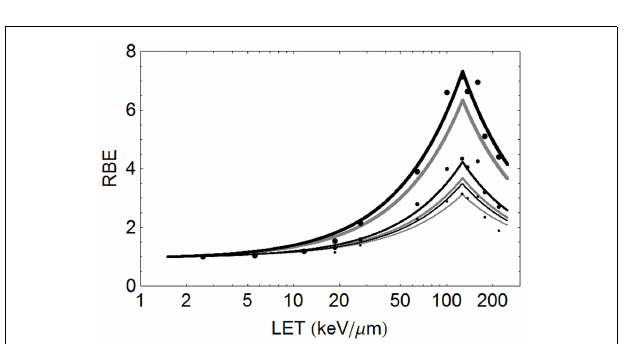
FIGURE 4 | Mono-energetic alpha particle data of Barendsen (with large points indicating 50% survival, medium sized points 10% survival, and the smallest points 5% survival, using the proposed model to provide fit lines, with black indicating use of parameters ααα L === 0.16Gy (cid:0)(cid:0)(cid:0) 1 , ααα U === 1.31Gy (cid:0)(cid:0)(cid:0) 1 , βββ L === 0.046Gy (cid:0)(cid:0)(cid:0) 2 , βββ U === 0.15Gy (cid:0)(cid:0)(cid:0) 2 and gray using parameters ααα L === 0.15Gy (cid:0)(cid:0)(cid:0) 1 , ααα U === 1.35Gy (cid:0)(cid:0)(cid:0) 1 , βββ L === 0.03Gy (cid:0)(cid:0)(cid:0) 2 , βββ U === 0.08Gy (cid:0)(cid:0)(cid:0) 2 . The thickest lines are for 50% survival, medium lines for 10% survival, and thinnest lines for 5% survival.